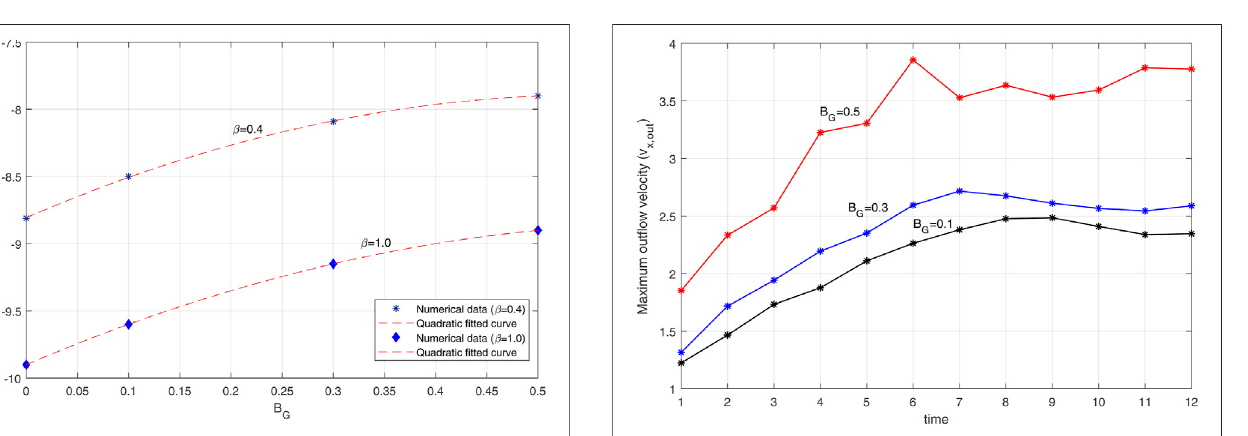
FIGURE6| Instability growthratewithuniformguide fi eldfor β (cid:1) 0.4and β (cid:1) 1.0.